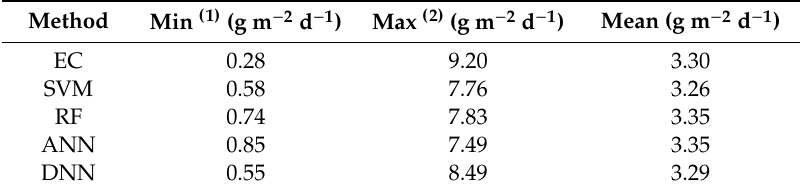
Table 2. Statistics of daily gross primary productivity (GPP) at the Gwangneung site for the period between 2006 and 2015, measured by eddy covariance (EC) and predicted by support vector machine (SVM), random forest (RF), artificial neural network (ANN), and deep neural network (DNN).